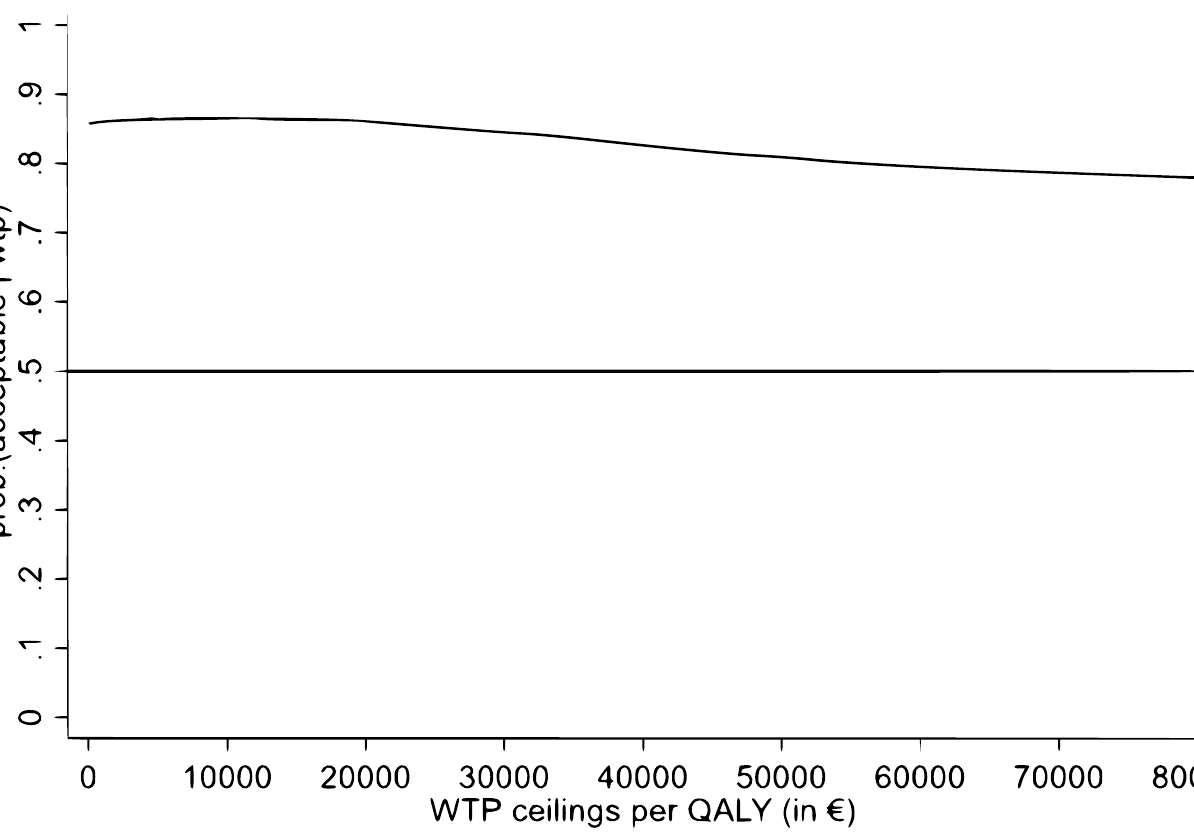
Fig 4. Acceptability curve reflecting the probability that blended ACT is cost-effective compared to CBT in terms of QALYs (cost-utility) at different willingness-to-pay ceilings.